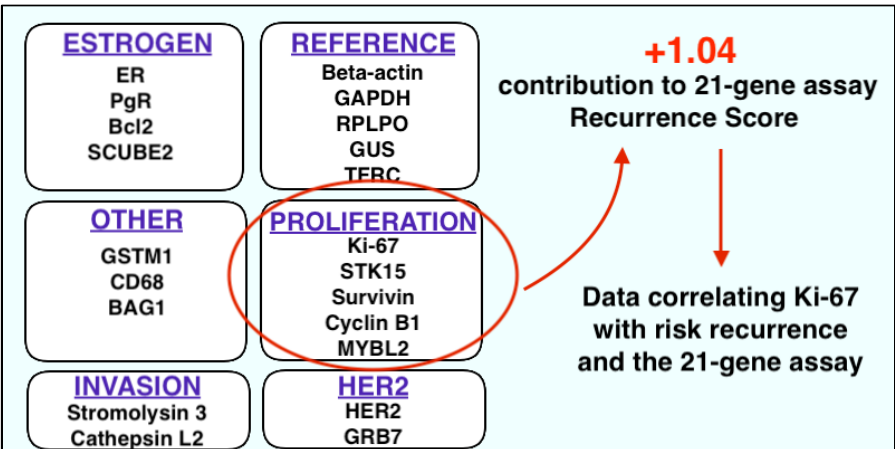
Figure 1. List of all genes assessed through the polymerase chain reaction in the OncotypeDX© 21-gene Recurrence Score signature (Genomic Health inc., Redwood City, CA, USA); proliferation contributes the largest proportion of included genes to the score with Ki-67 a key component of Ki-67 expression to the Recurrence Score through a number of techniques, including traditional immunohistochemistry [127] and novel machine learning techniques [114].